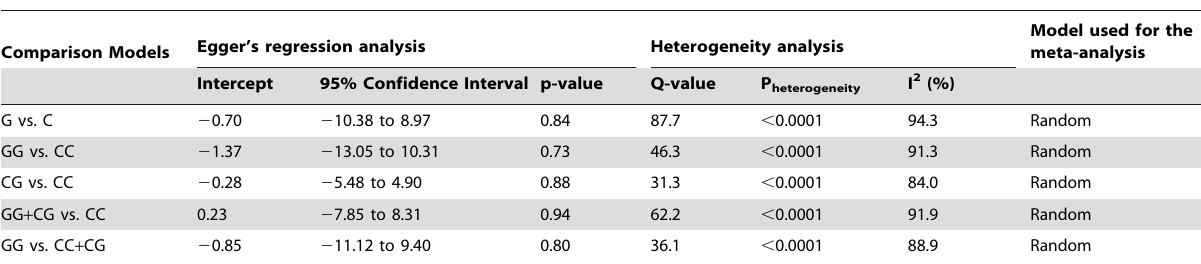
Table 3. Statistics to test publication bias and heterogeneity in the meta-analysis.